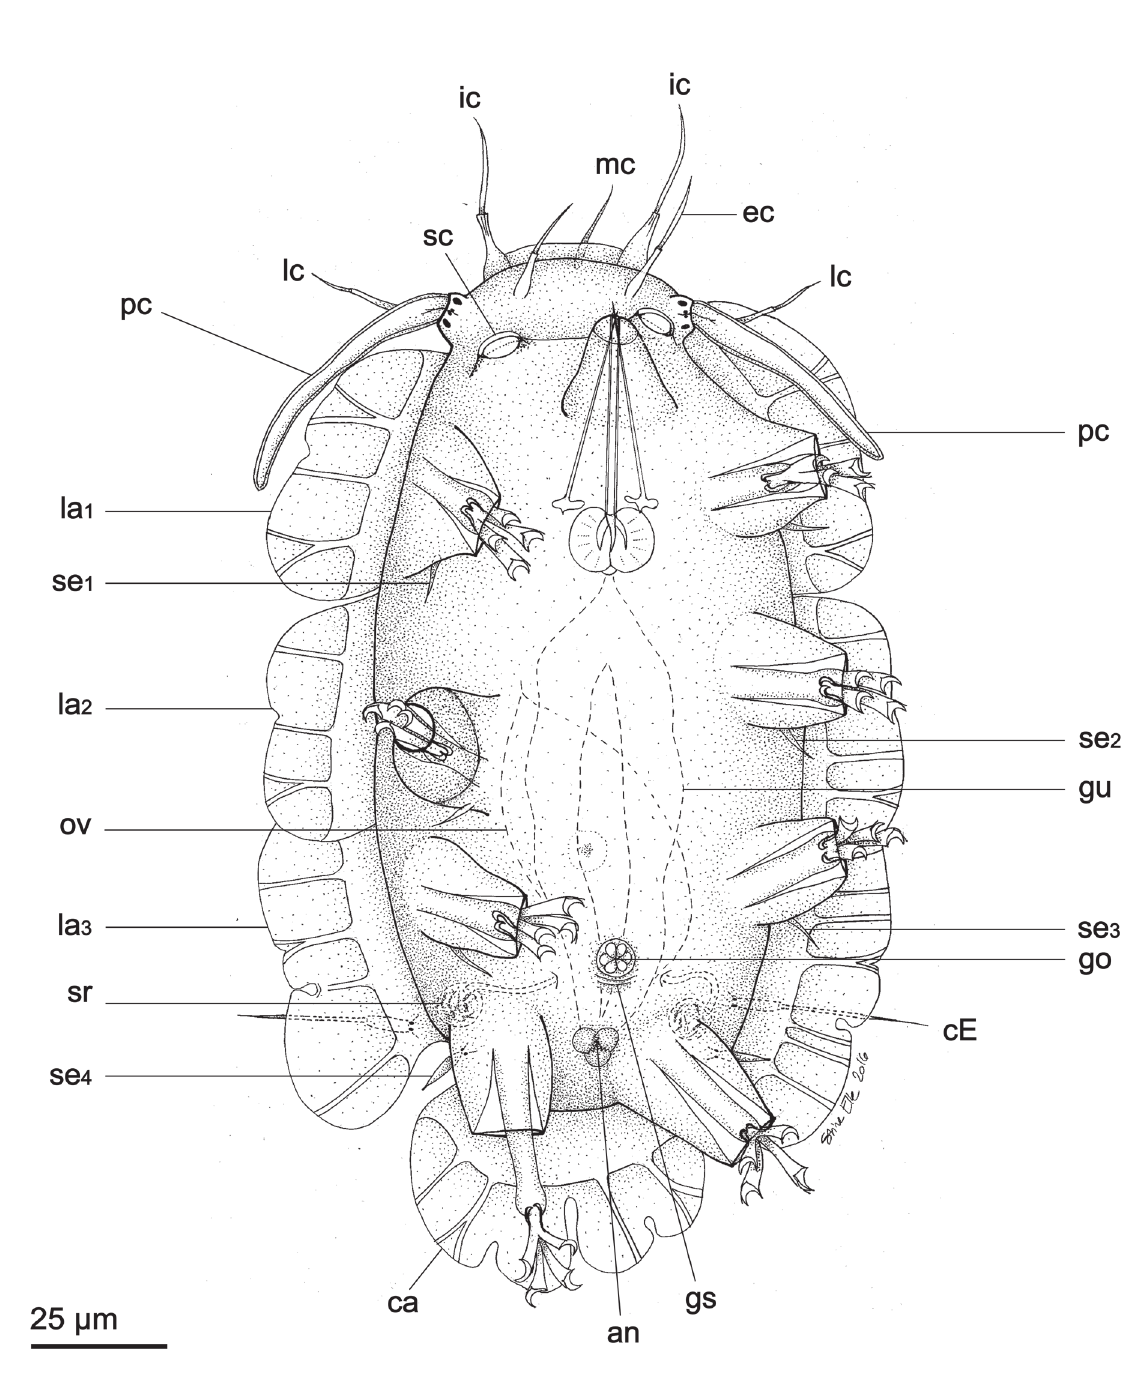
Fig. 12. Higginsarctus martini gen. et sp. nov., holotype, ♀ (NHMD-293903). Ventral overview. Abbreviations: see Material and methods. Drawing by Stine B.